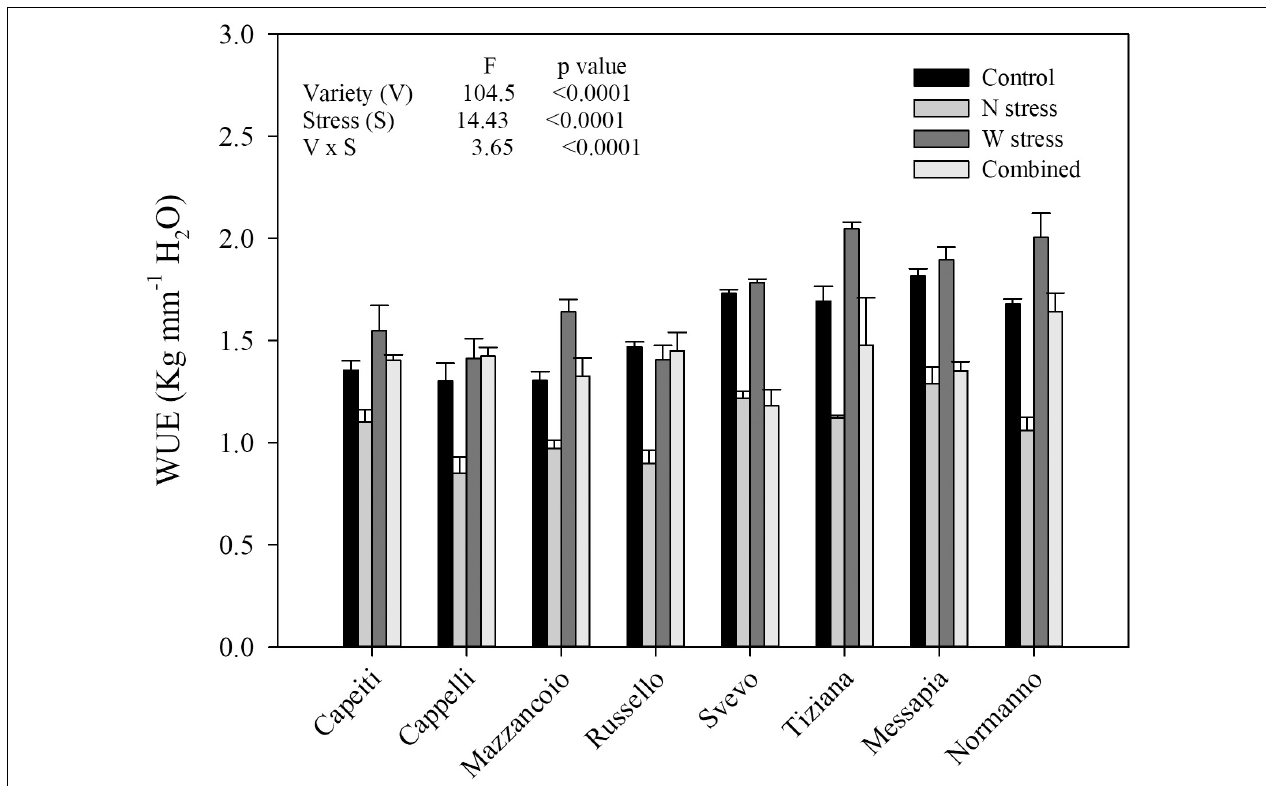
FIGURE 3 | Water use efficiency of eight durum wheat varieties under water and nitrogen stress alone or in combination in the field experiment. Values are means ( n = 5) ± SE.